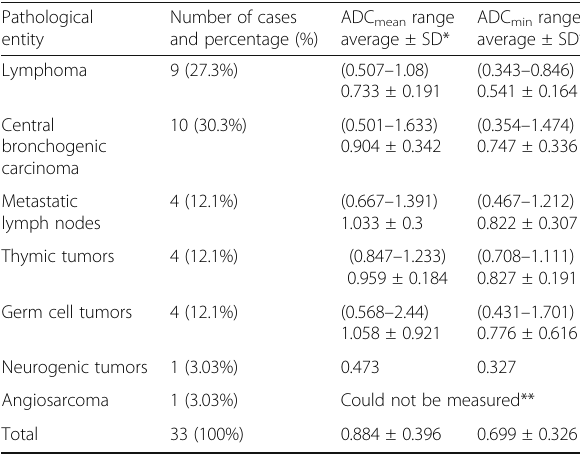
Table 5 Summary of ADC mean and ADC min values per